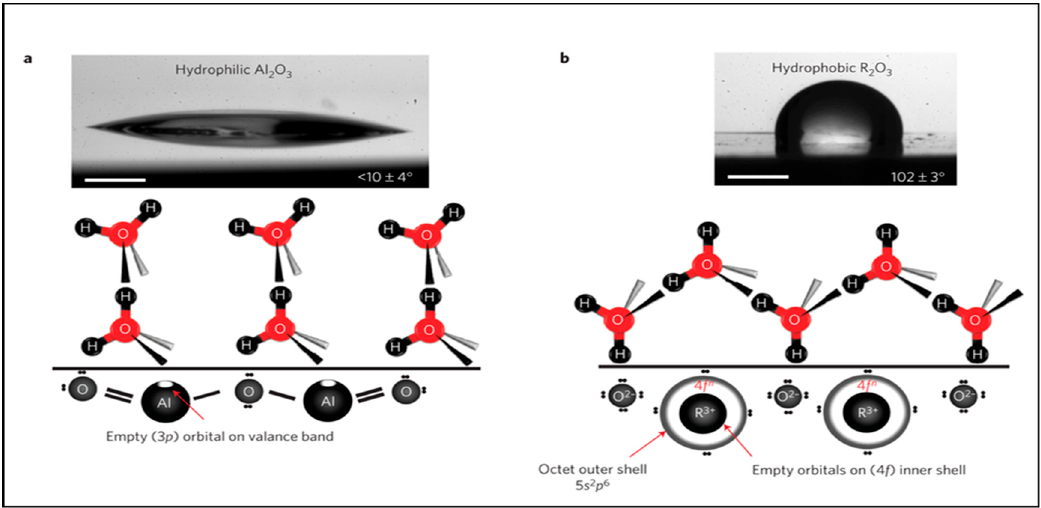
Figure 8. Water molecule orientation on aluminium (metal) oxide ( a ) and a REO ( b ) [96]. Reprinted with permission from Ref. [96]. Copyright 2013 Springer.